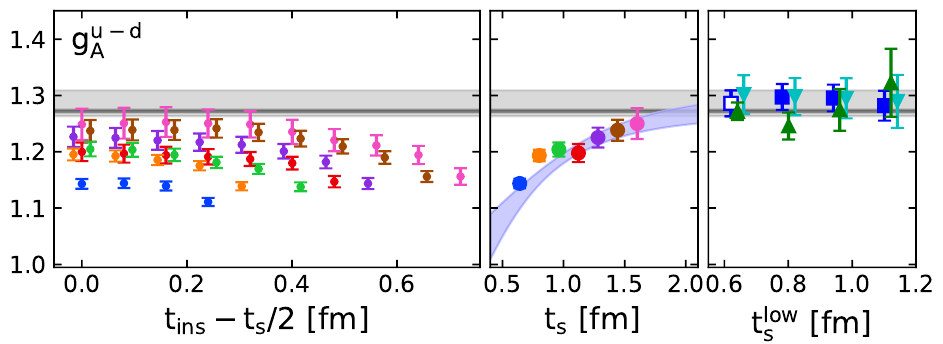
[fm] Figure 6: Left: The ratio of Eq. (3) as a function of the time separation t and the s time of the inversion t . Center: the values extracted from fitting the data of the left ins panel to a constant assuming ground state dominance. The blue band is the result of a two-state fit. Right: The values of extracted from a two-state fit as a function of M the lower value of t used in the fit, t low (filled blue squares) and from three-state fits s s (light blue down triangles). The filled green triangles are the values of extracted M using the summation method of Eq. (4). The open blue square is the selected value for with the associated error shown with the grey band across the three panels. M = 1.273 ( 2 ) . The darker band shows the PDG value of g u − d A